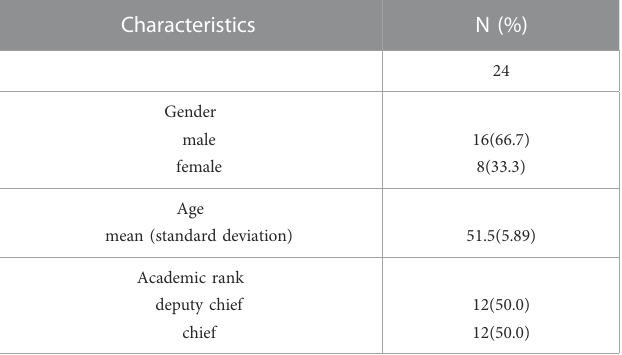
TABLE 2 Characteristics of the attending physicians.